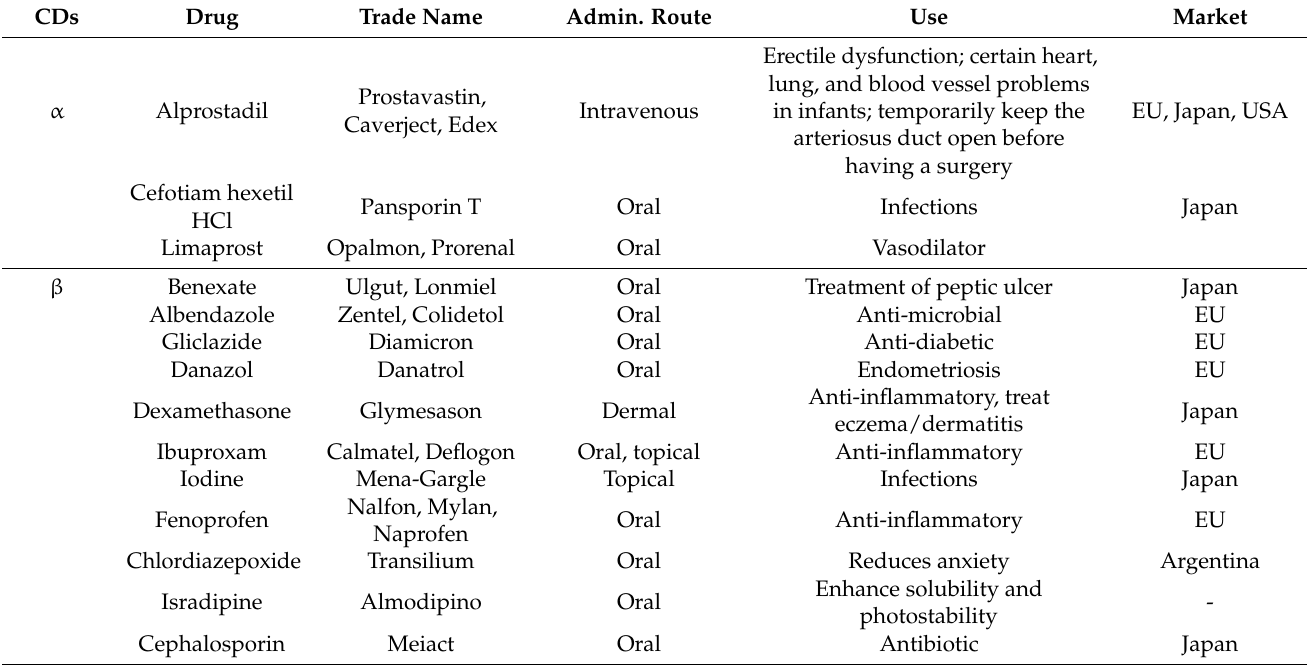
Table 4. Examples of some cyclodextrins (CDs) studied in pharmaceutical applications. Adapted from [87,96–100].